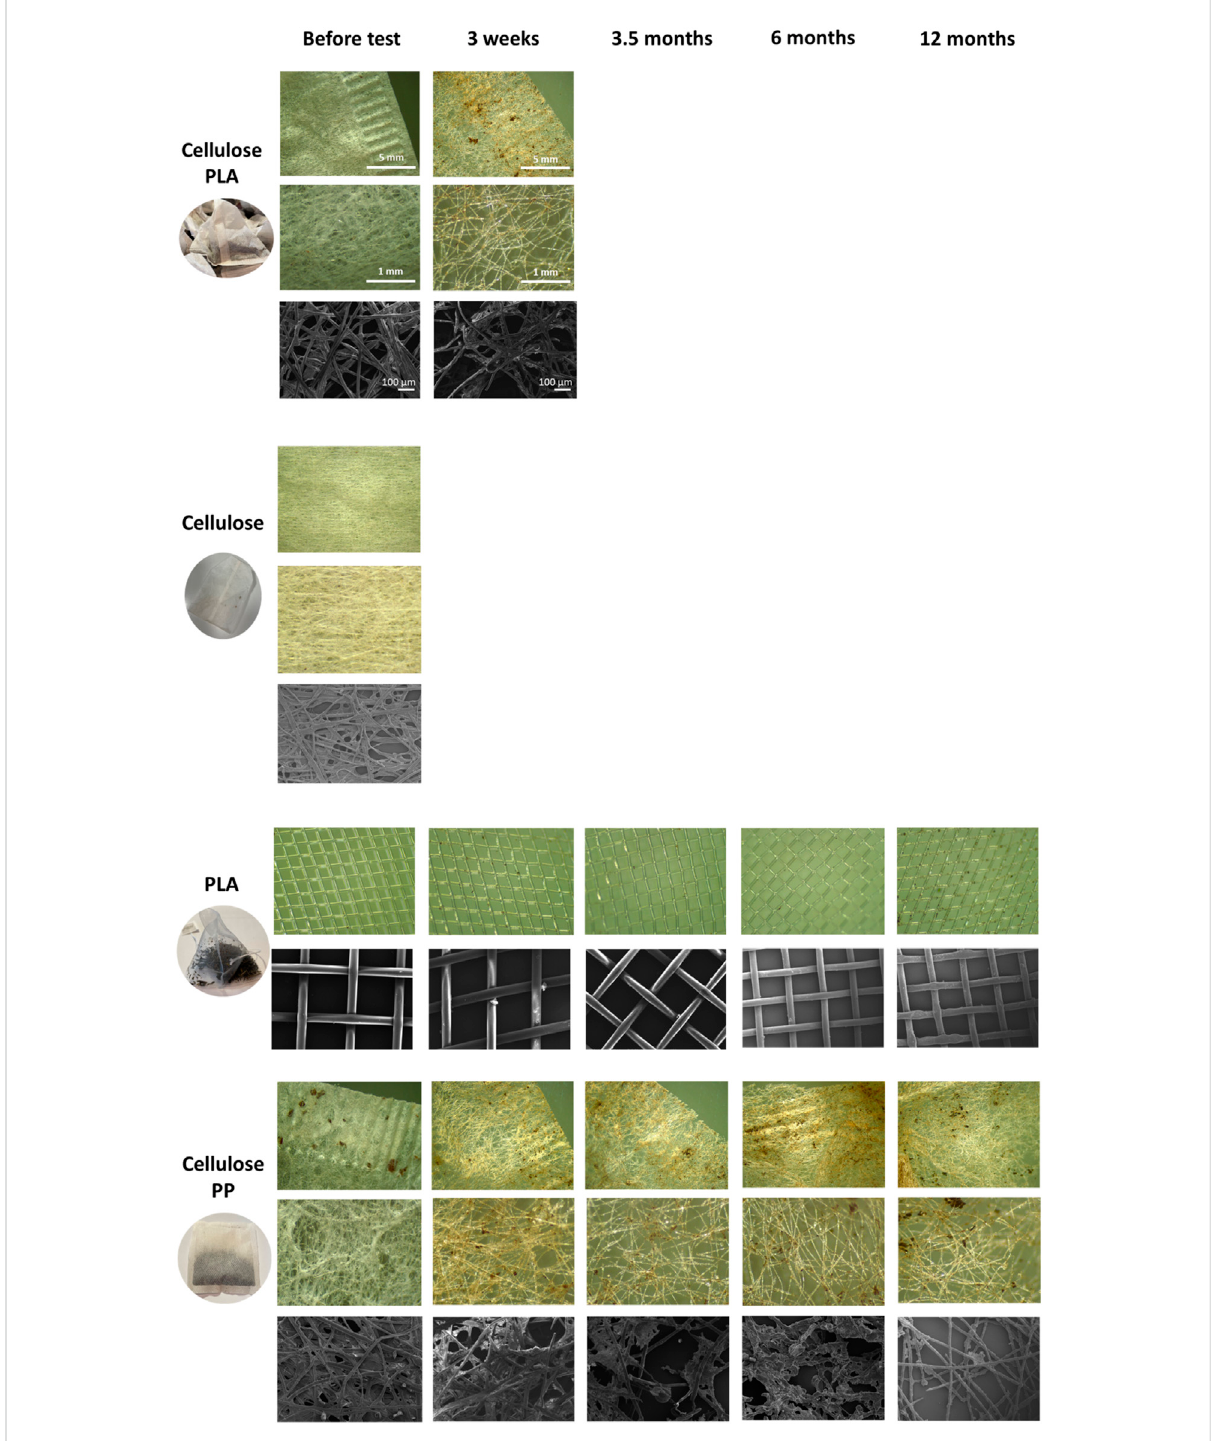
FIGURE 1 Light microscopy and SEM photos of the teabag polymer types tested in this study, PLA-cellulose blend, cellulose, PLA and PP-cellulose blend. Scale is shown in PLA-cellulose rows for all